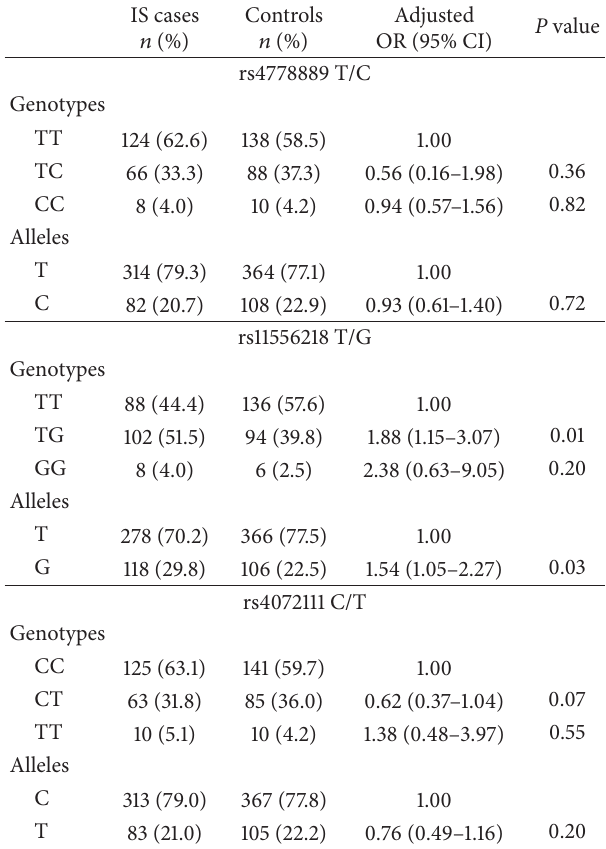
Table 1. The genotype and allele frequencies of the